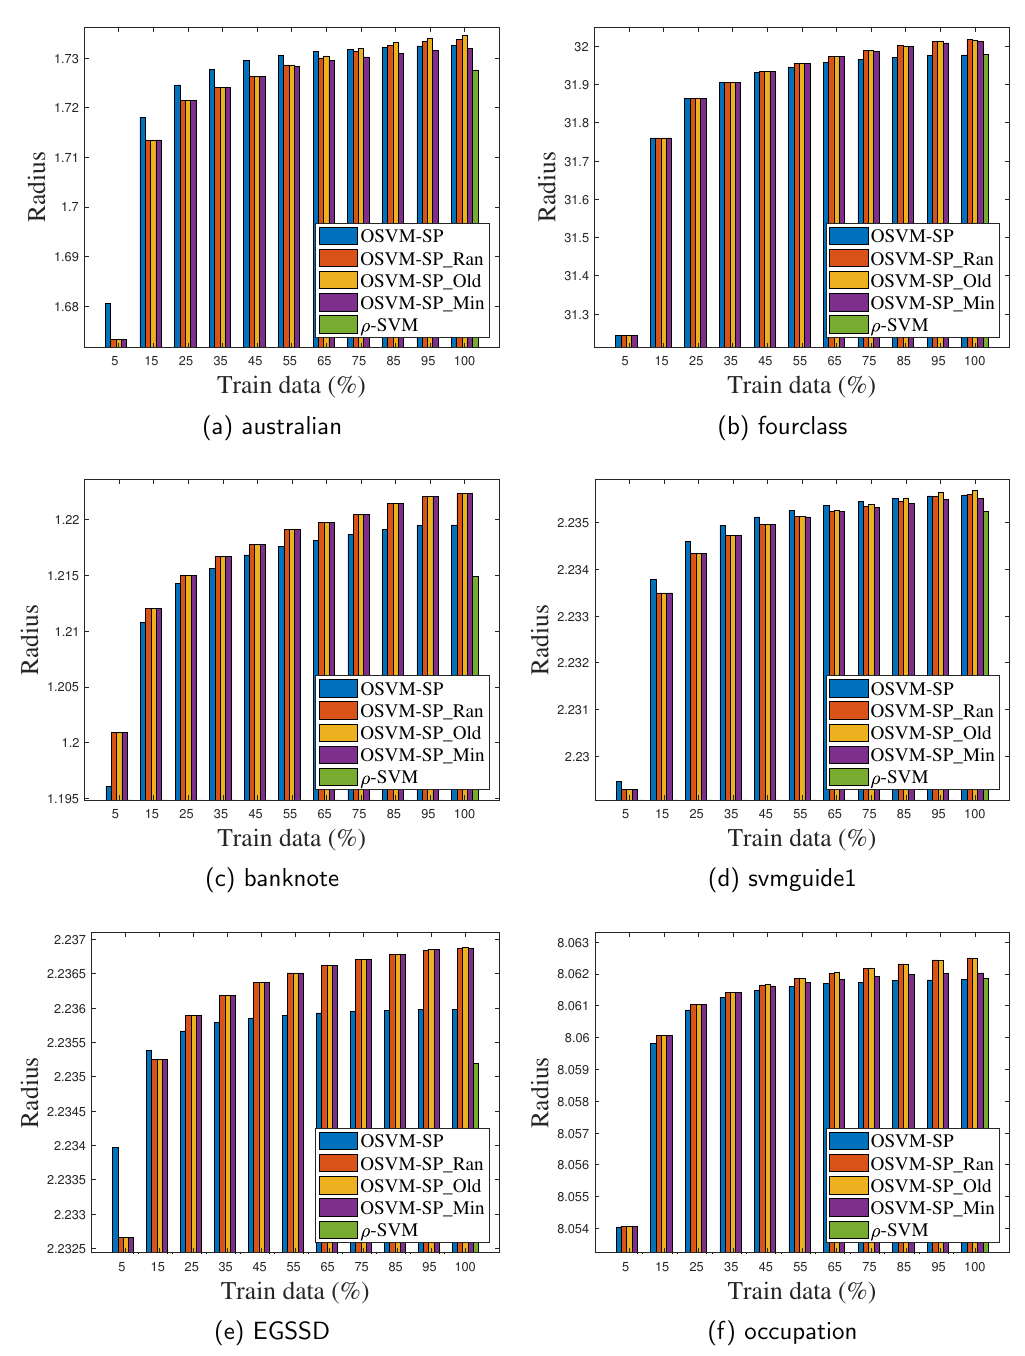
Figure 8. Radius with varying amounts of training